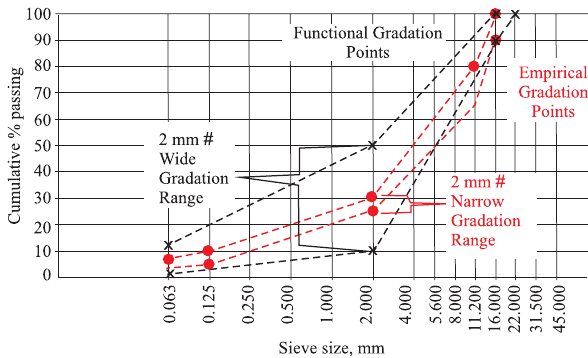
Fig. 2. Comparison gradation points for empirical and functional asphalt mixtures designing method for binder course dense